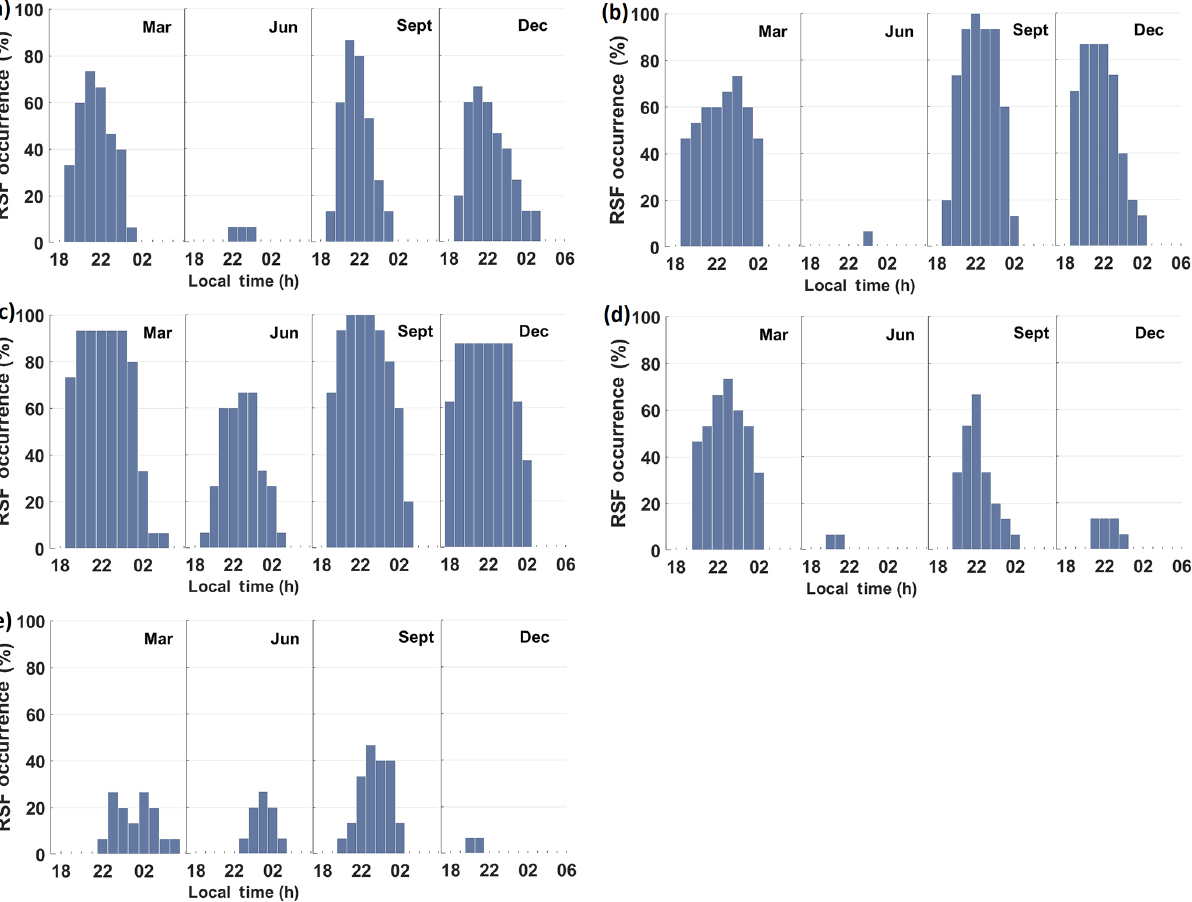
Figure 4. Occurrence rate of RSF during the LSA period at the (a) Jicamarca, (b) Fortaleza, (c) Ilorin, (d) Chumphon and (e) Kwajalein